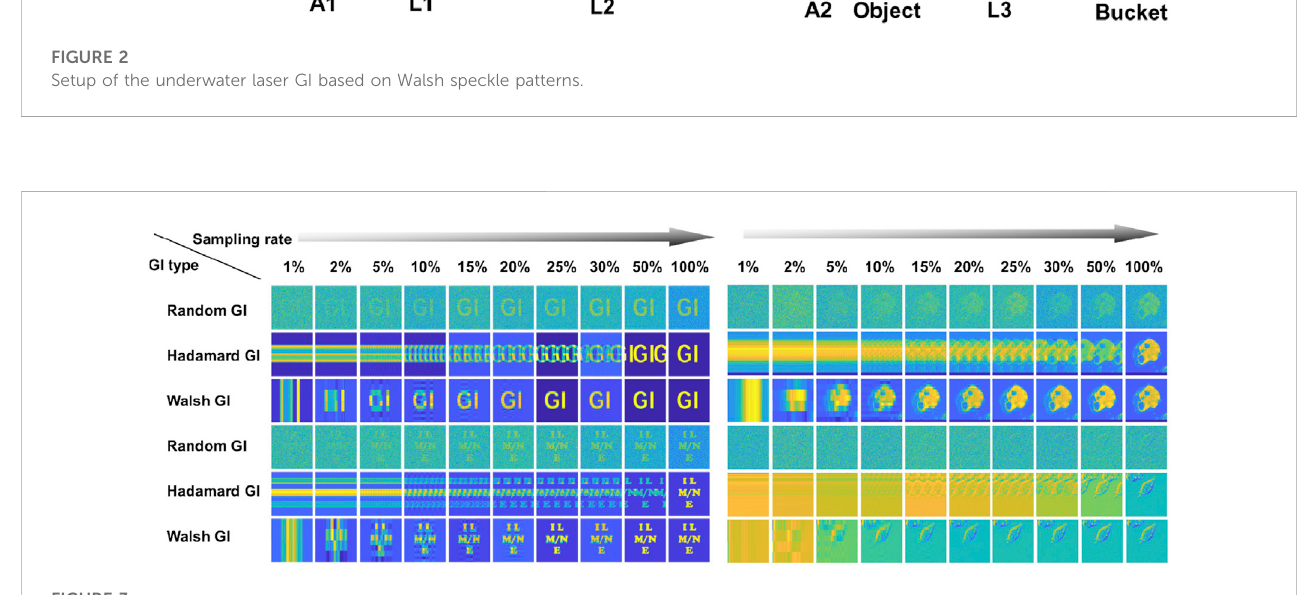
FIGURE 3 Simulated results of laser GI based on random, Hadamard, and Walsh speckle patterns in the noiseless environment.